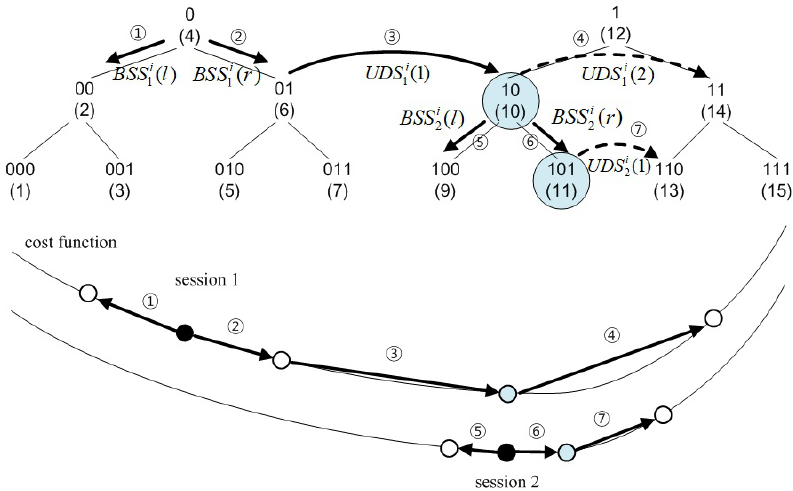
Figure 4. Example of two successive cDEAS sessions from string 0 to string